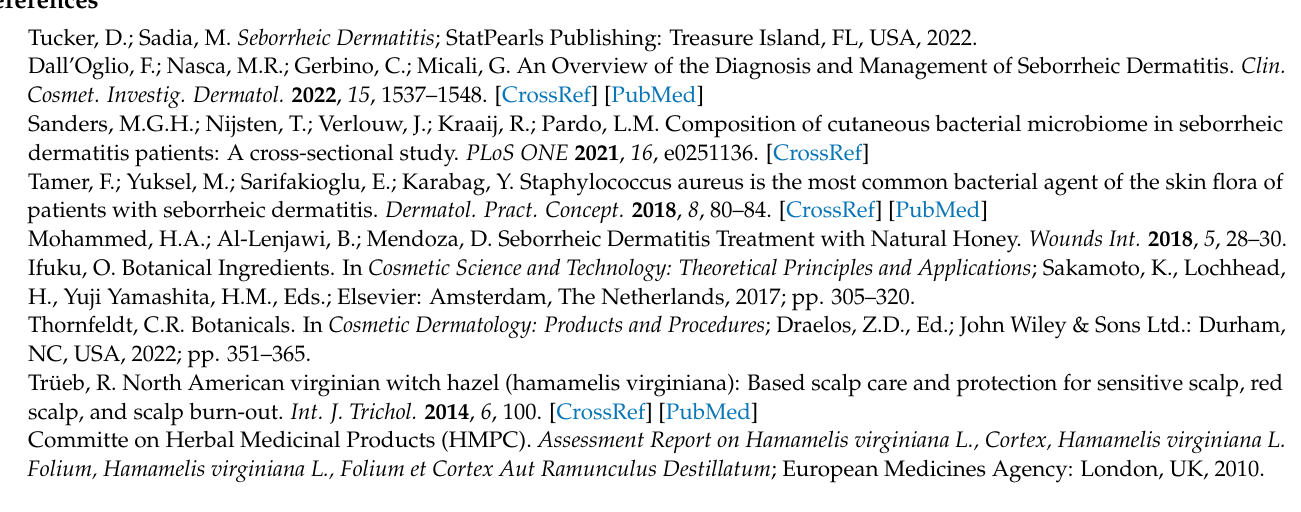
of compounds analyzed from the HM; Figure S23: Ishikawa diagram, Figure S24: Response surface plots; Table S1: FMEA risk assessment, Table S2: LC/MS mobile-phase gradient